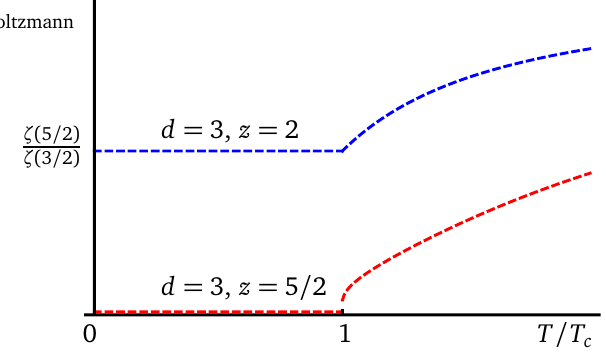
Figure 1: We give a representation of the speed of sound of the Bose gas for T ≤ T are three distinct regions: speed of sound as in (179), speed of sound is zero v critical temperature and thus speed of sound as in (177).